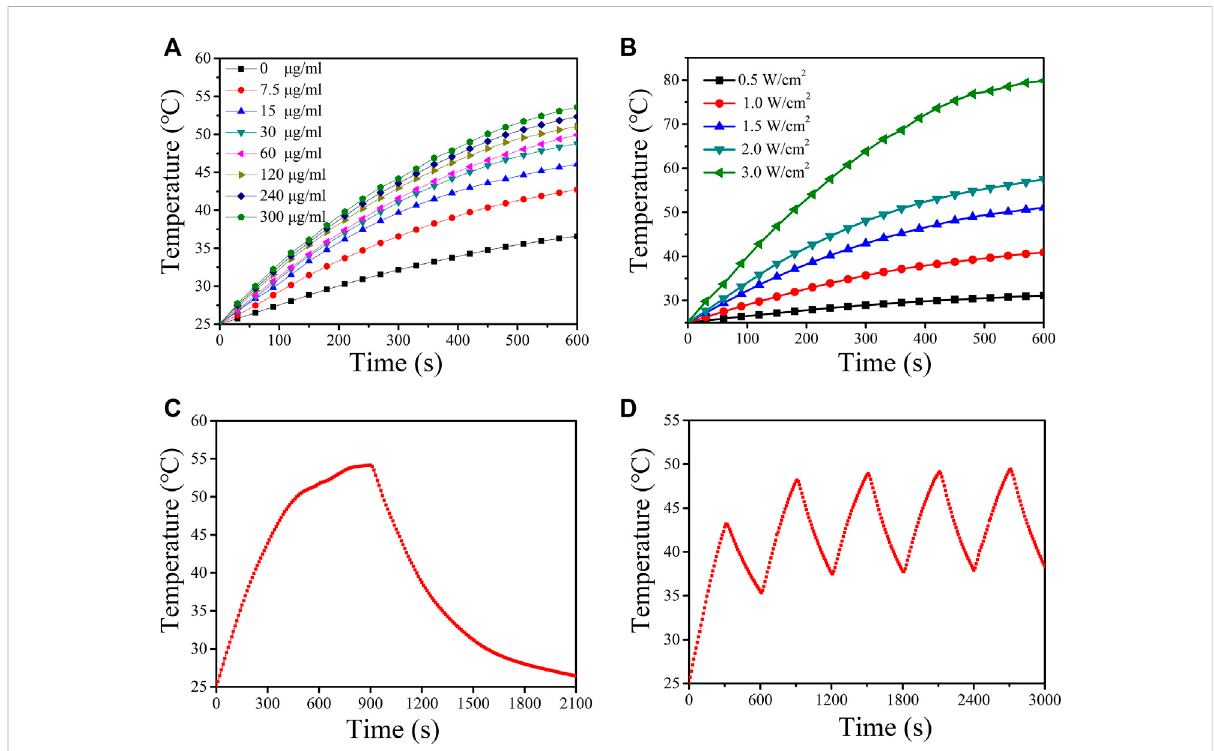
FIGURE 3 Photothermal effect of CuS-BSA NPs. (A) Photothermal conversion of CuS-BSA NPs aqueous solution with different concentrations in vitro under irradiation of a 980 nm laser (1.5 W/cm 2 ) for 10 min. (B) Photothermal conversion of CuS-BSA NPs aqueous solution (120 μ g/mL) with a 980 nm laser at different power densities for 10 min. (C) Temperature curve of CuS-BSA NPs aqueous solution (120 μ g/mL) during irradiating with 980 nm laser (1.5 W/cm 2 ) and cooling process. (D) The heat-cool loop of CuS-BSA NPs aqueous solution (120 μ g/mL) in vitro under irradiation of a 980 nm laser (1.5 W/cm 2 ) for fi ve heat-cool